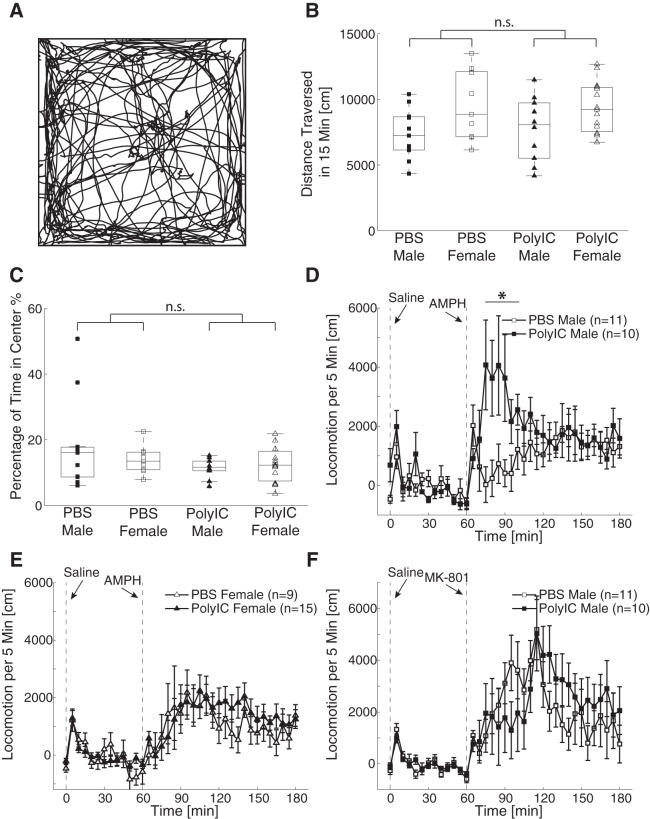
Effects of MIA on open field exploration, amphetamine- and MK-801-induced hyperlocomotion. A, Example locomotion trajectory during 15 min in open field. B, Distance traversed in 15 min in open field. C, Percentage of time spent in the center in 15 min in open field. The configuration of B, C is the same as in Figure 1. D, E, Time course of locomotion after amphetamine injection in males and females, respectively. F, Time course of the locomotion after MK-801 injection in the male animals. Error bars indicate SEM. The vertical dashed lines at 0 and 60 min represent the time of saline and amphetamine/MK-801 injection, respectively. The locomotion activity is subtracted by baseline activity. *p < 0.05.